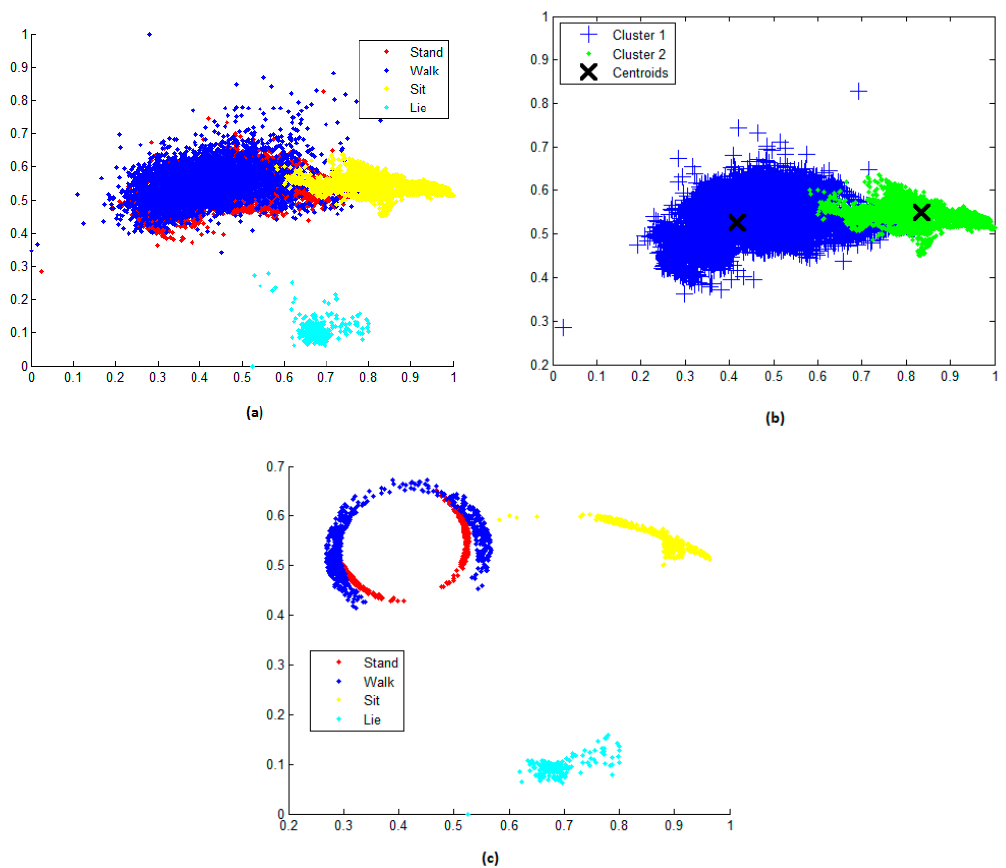
Figure 4. ( a ) PCA is applied to acc (cid:2934),(cid:2935),(cid:2936),(cid:2921) (data distribution corresponds to the first and second principal components); ( b ) Classes are extracted in pairs ( x (cid:2924) , x ,(cid:2923) ) , centroids are extracted